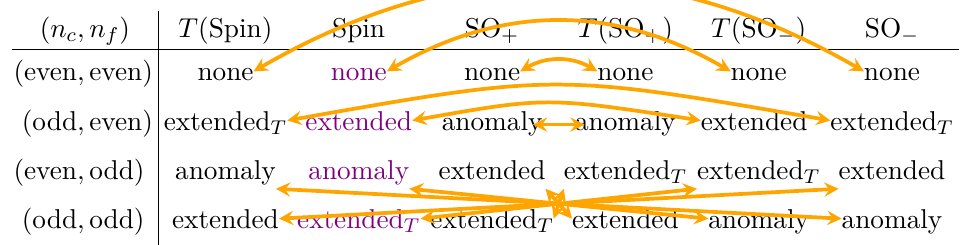
Table 5 . The symmetry structure of so (2 n c ) QCD with 2 n f flavors, as deduced from the 2-group structures found in section 2 and from the SL(2 , Z ) action discussed in this section. The symmetry 2 structure of the Spin case, colored in purple, will be checked independently in section 4. The action of Intriligator-Seiberg duality is also superimposed using orange